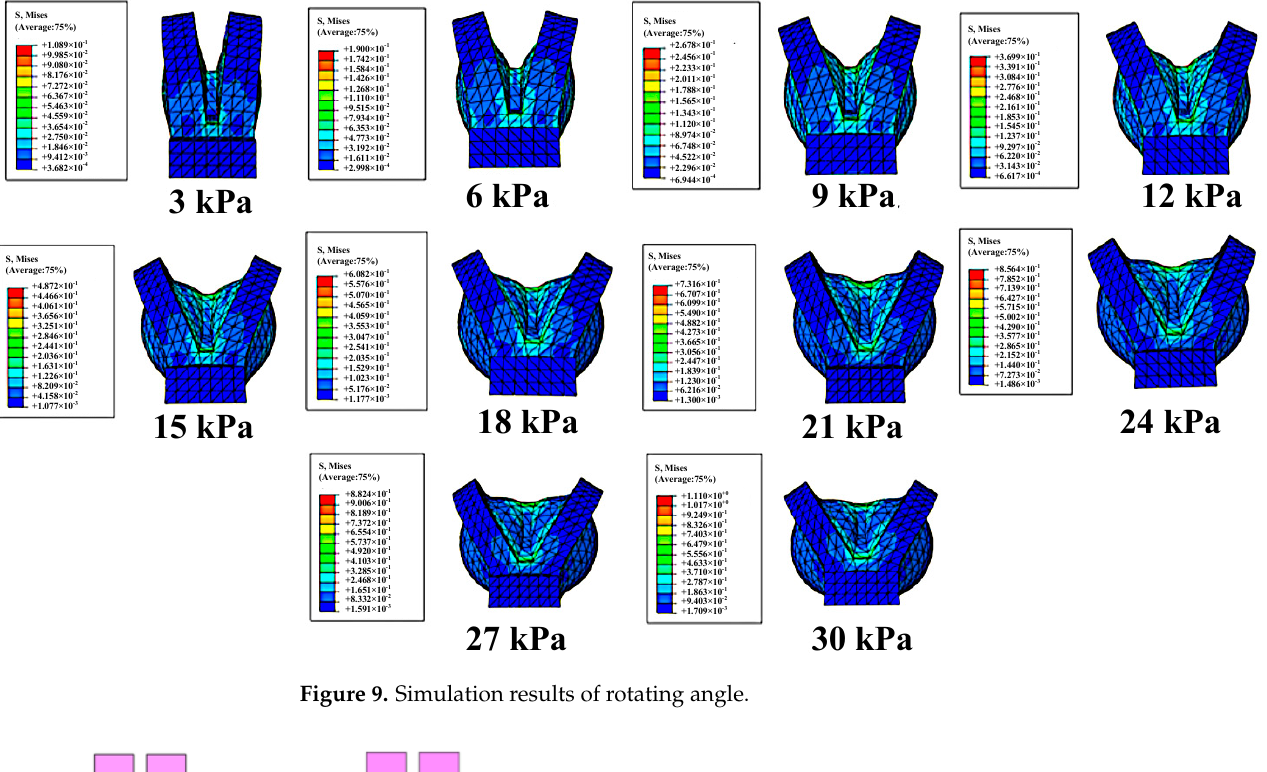
Figure 9. Simulation results of rotating angle.